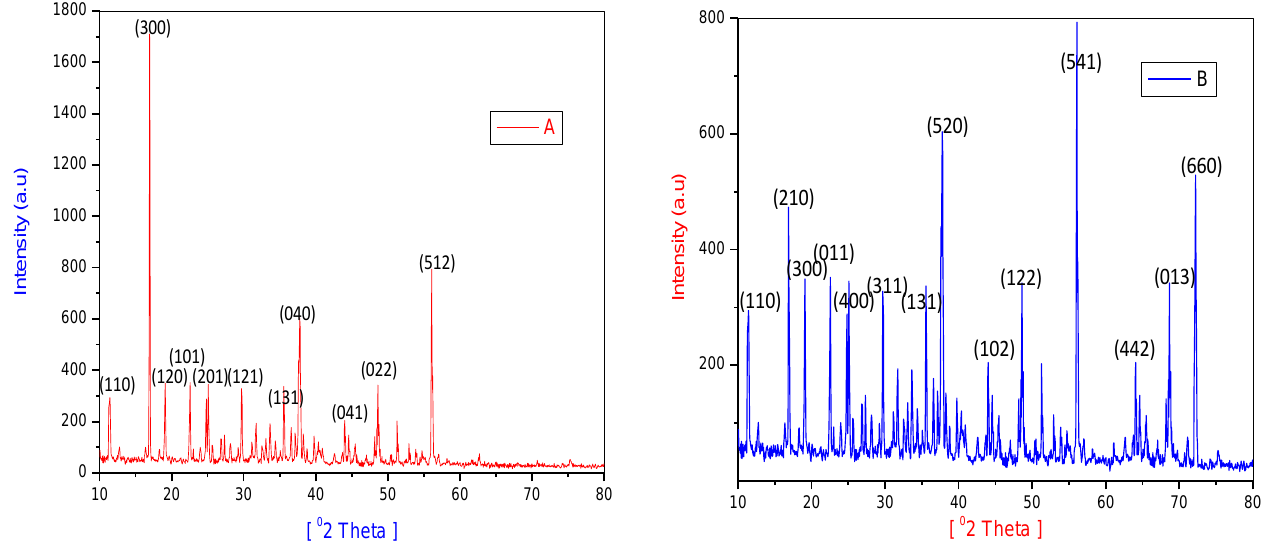
Figure 6. PXRD patterns of ( A ) Co(II)complex and ( B ) Ni(II)complex. The lattice constants for the Co(II) complex are a = 10.82, α = 90 ◦ , b = 9.24(4), β = 90 ◦ , c = 6.03(2), γ = 90 ◦ , V = 65.25 and the crystal system Orthorhombic, Bravais, Primitive (P) are the three types of polygons.